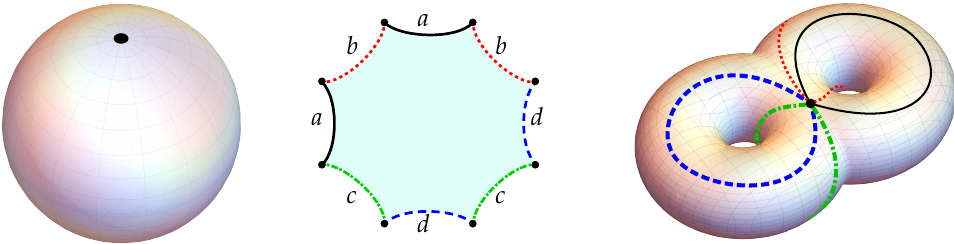
Figure A1. A disc ( middle , suggesting a hyperbolic metric), may be compactified to a sphere ( left ) by identifying the entire boundary with the “North pole.” Identifying the boundary segments in the indicated interleaved fashion produces the genus-2 Riemann surface ( right , a basis of 1-cycles identified with the indicated boundary